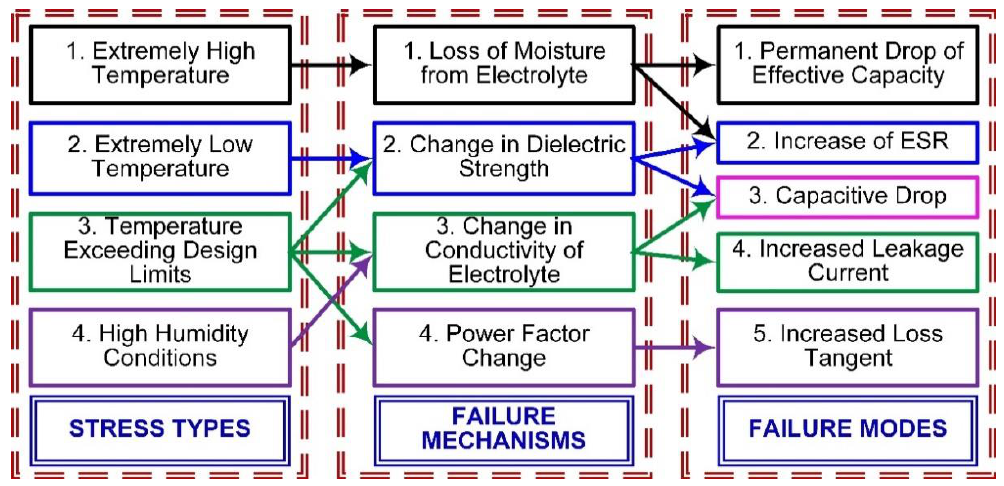
Figure 6. Stresses, failure mechanism, and failure modes in the capacitor .